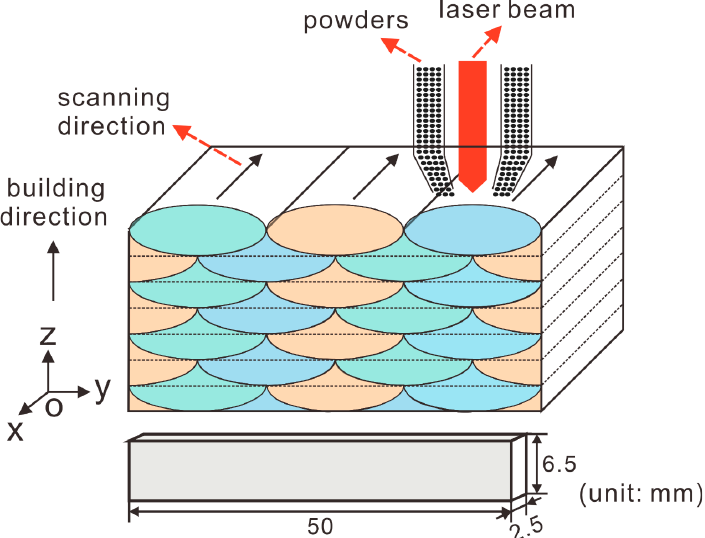
Figure 1. Schematic diagrams of LMD process of TC11 alloy and EPT sampling on the yoz